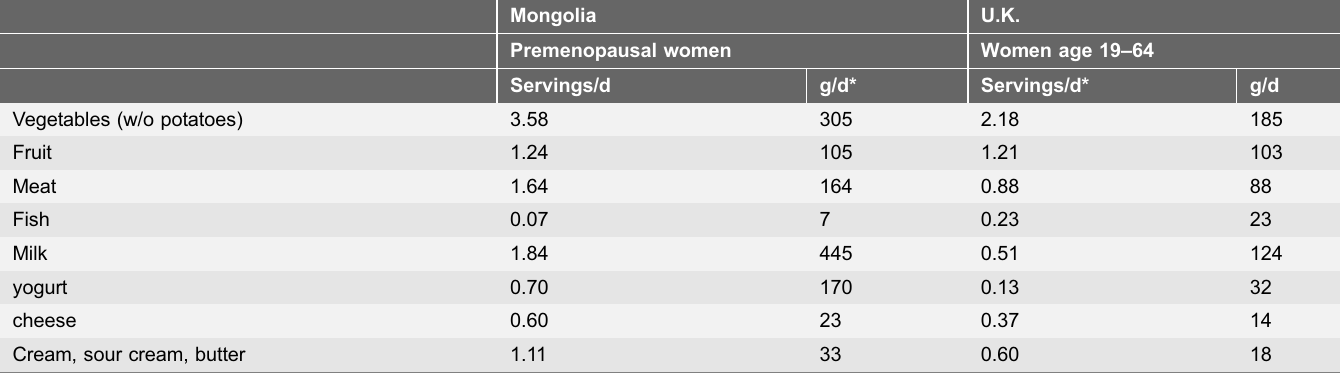
Table 2. Components of Mongolian and U.K.